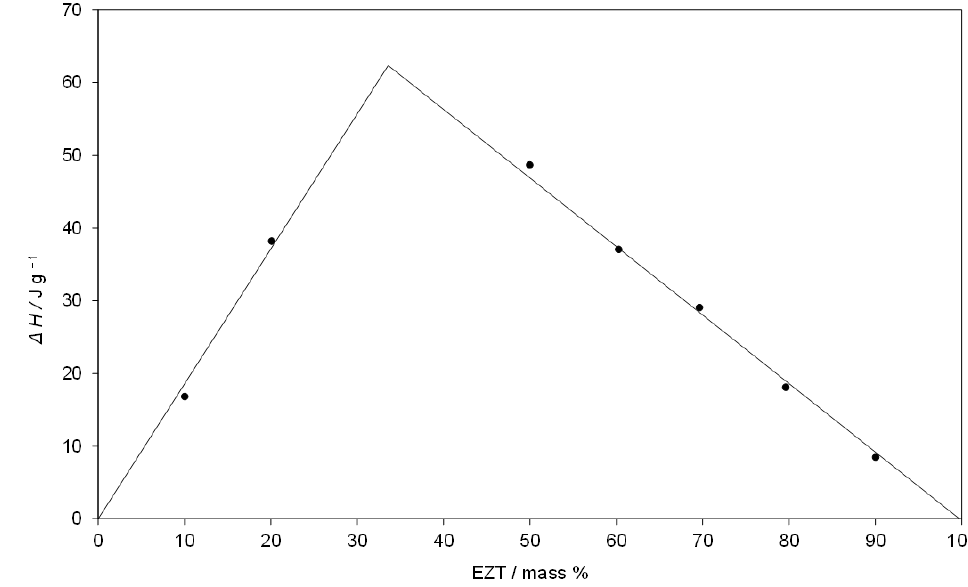
Figure 3. Tamman’s triangle of eutectic melting enthalpy, Δ H at 117.5 °C versus EZT mass %.